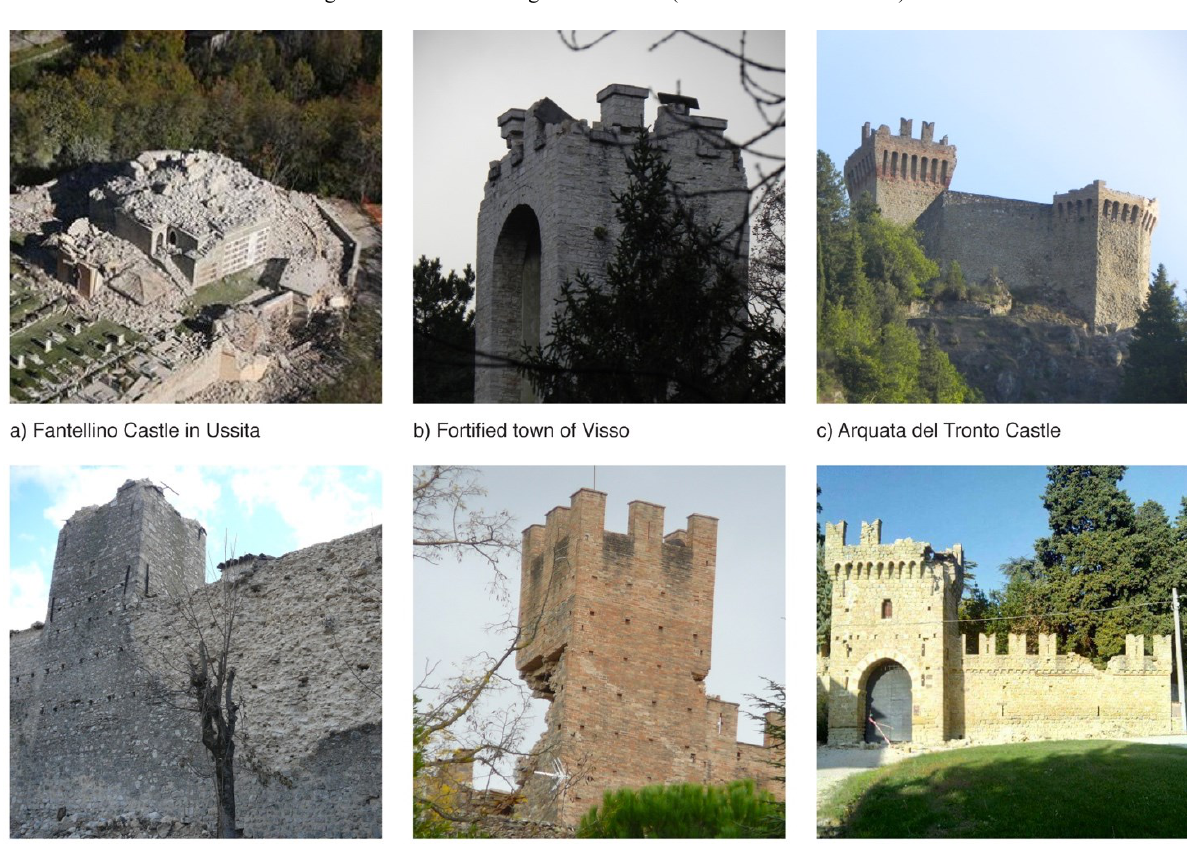
Figure 9. Damaged fortified buildings after the seismic sequence started in August